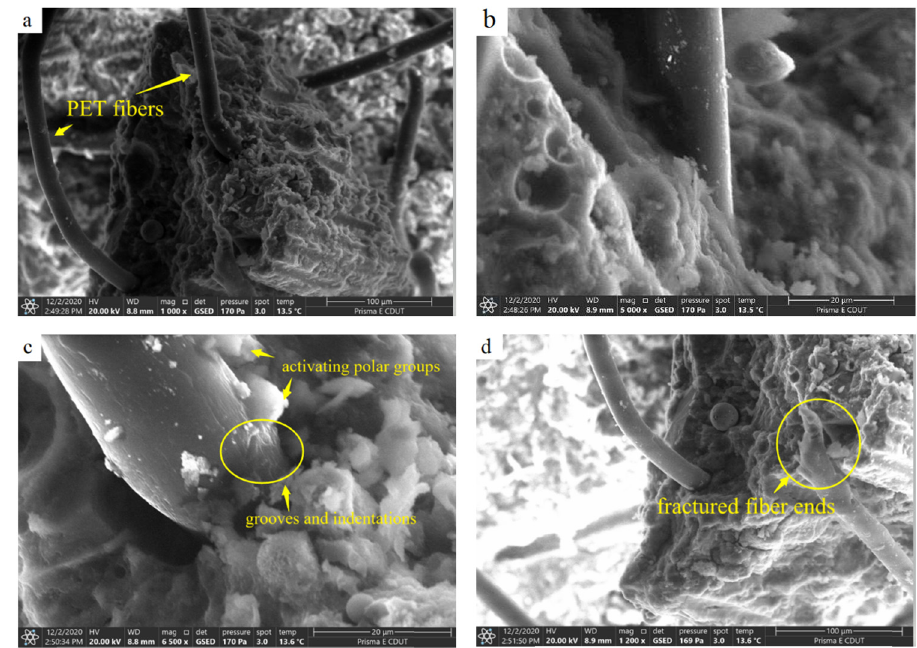
Figure 14: PFCGGPC - 1.0. ( a ) mag1000 × PET fi bers ( b ) mag5000 × PET fi bers ( c ) mag6500 × groups and grooves and indentations ( d ) mag1200 × fractured fi ber